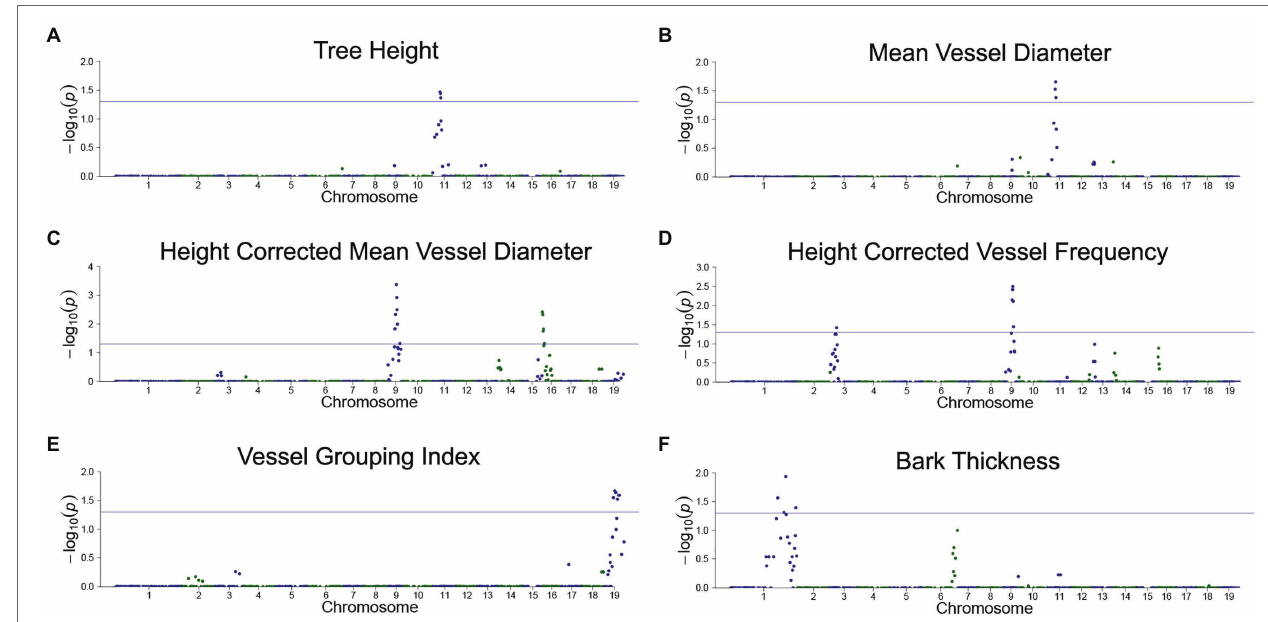
FIGURE 6 | Dosage-dependent quantitative trait loci (dQTL) of traits. Traits with significant dQTL included tree height (A) , MVD (B) , cMVD (C) , cVF (D) , VGI (E) , and bark thickness (F) . Genomic bin position is plotted against the − log10 of the value of p for each correlation test. A significance threshold corresponding to a value of p of 0.05 is depicted as a blue horizontal line. The values of p were adjusted using a relaxed Bonferroni correction (see section “Materials and Methods”).